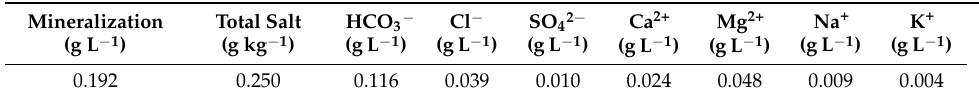
Table 2. Chemical properties of irrigation